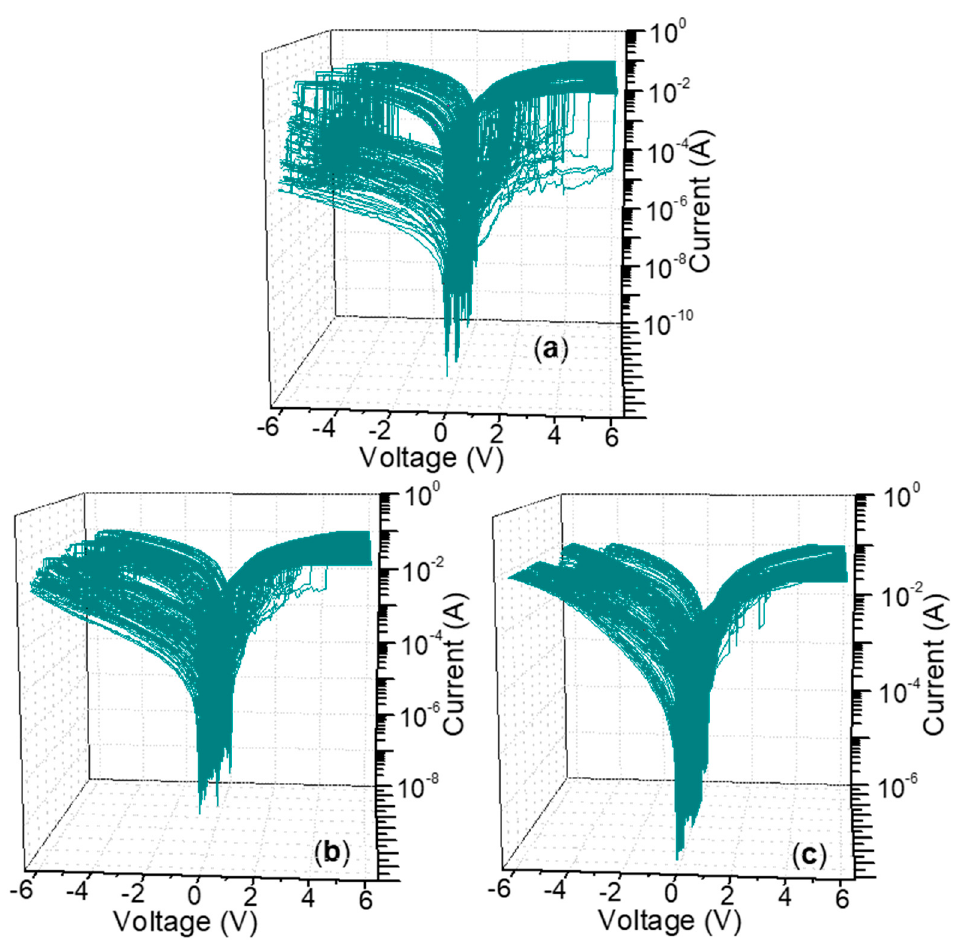
Figure 9. ( a - c ) Consecutive I – V cycles of the electrically ternary biomemory behaviors for ITO/CS:GO/Ni with weight ratio of chemical component 2:1, 5:1, and 10:1 w/w, respectively.